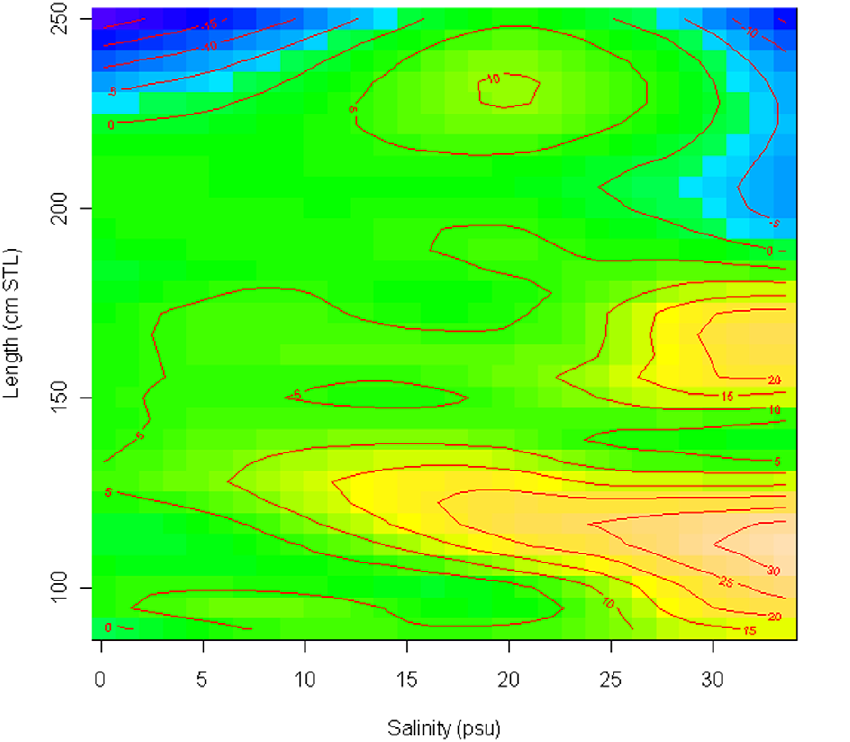
Figure 8. Predictions of river distance (contour lines, colors) based on salinity and sawfish length from the best fitting Generalized Additive Model for Pristispectinata in the Caloosahatchee River. Blues indicate areas downstream of the study area, green indicates low reaches of the study area, yellow mid-reaches and white upper reaches.